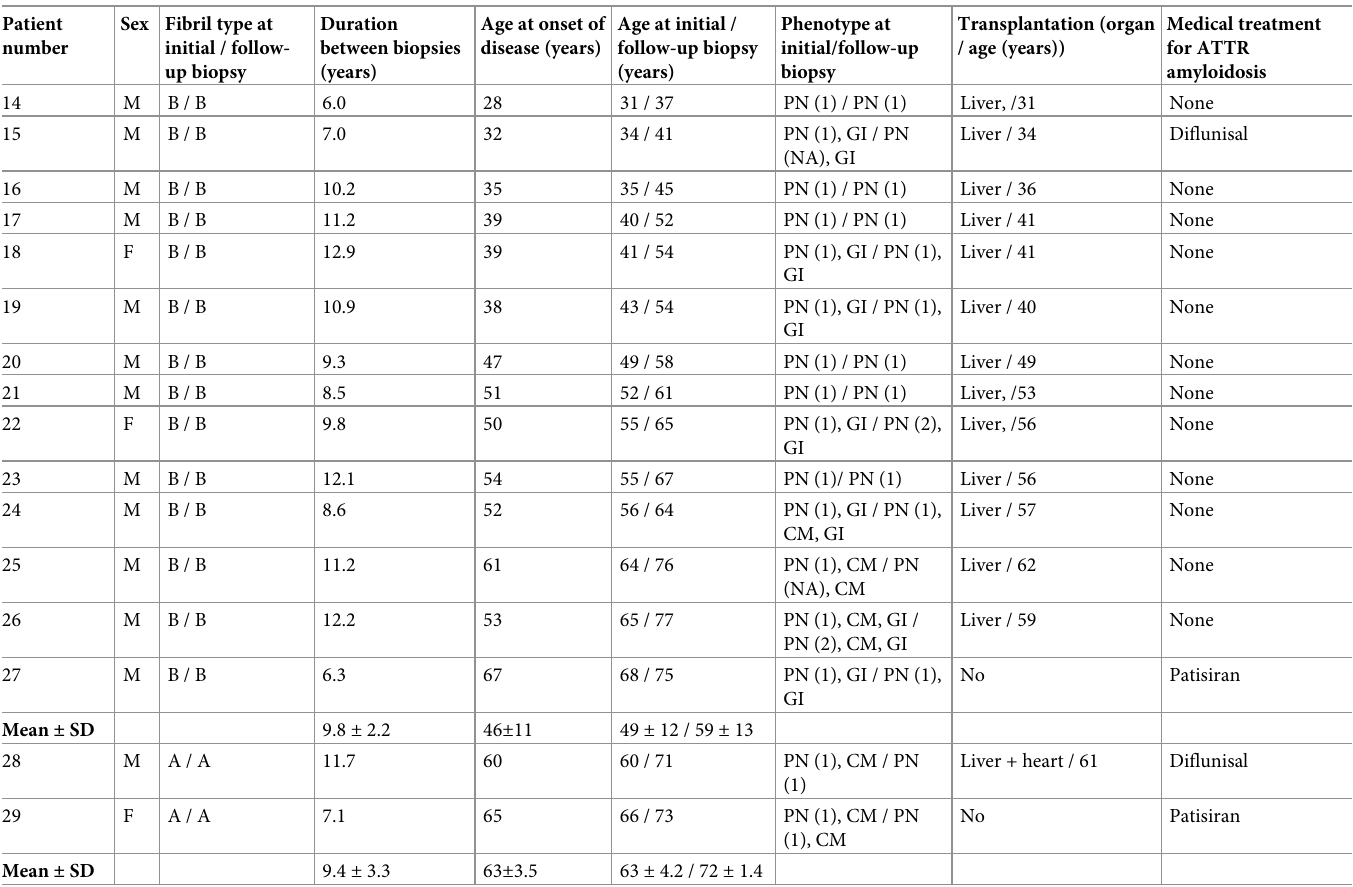
Table 2. Patients from whom a long-term follow-up biopsy was collected for this study. Patient Sex Fibril type at number initial /